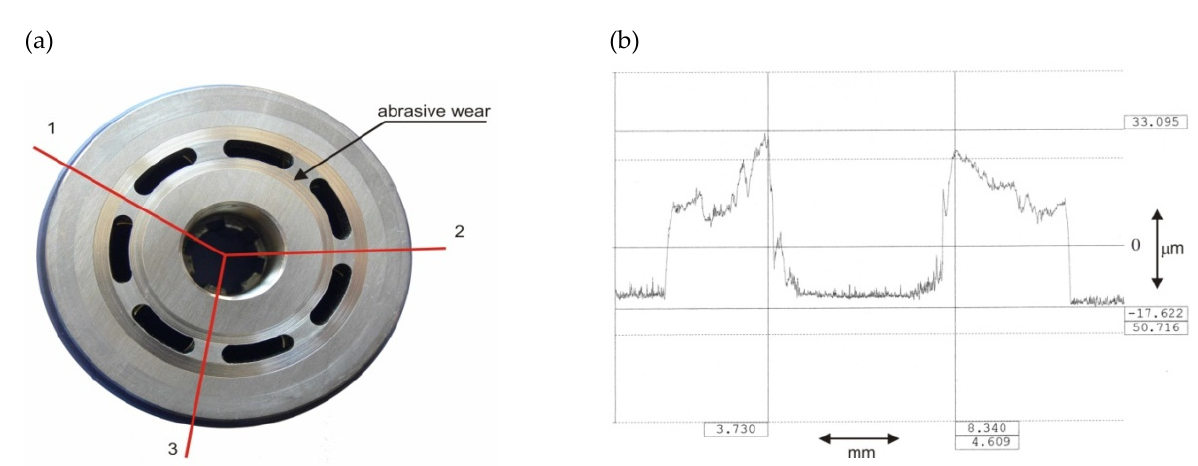
Sensors 2021 , 21 , x FOR PEER REVIEW Figure 3. View of worn rotor face and its wear profile: ( a ) worn rotor face: 1,2,3 wear measurement directions, ( b ) wear profile.